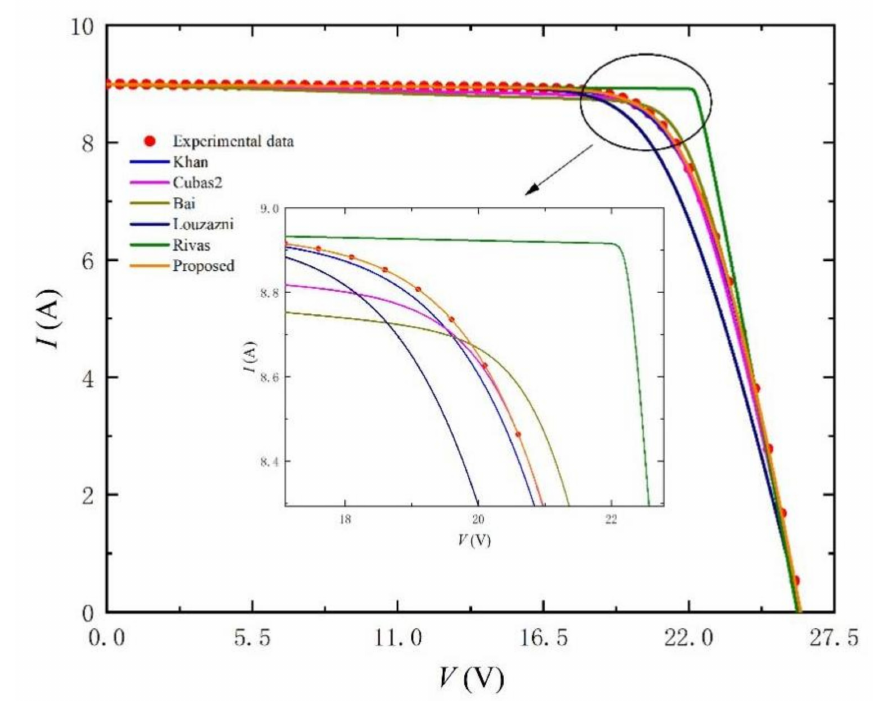
Figure 3. I-V curves simulated by using setting initial value and the extracted parameters listed in Table 1 at G = 1000 W/m 2 and T = 25 ◦ C.